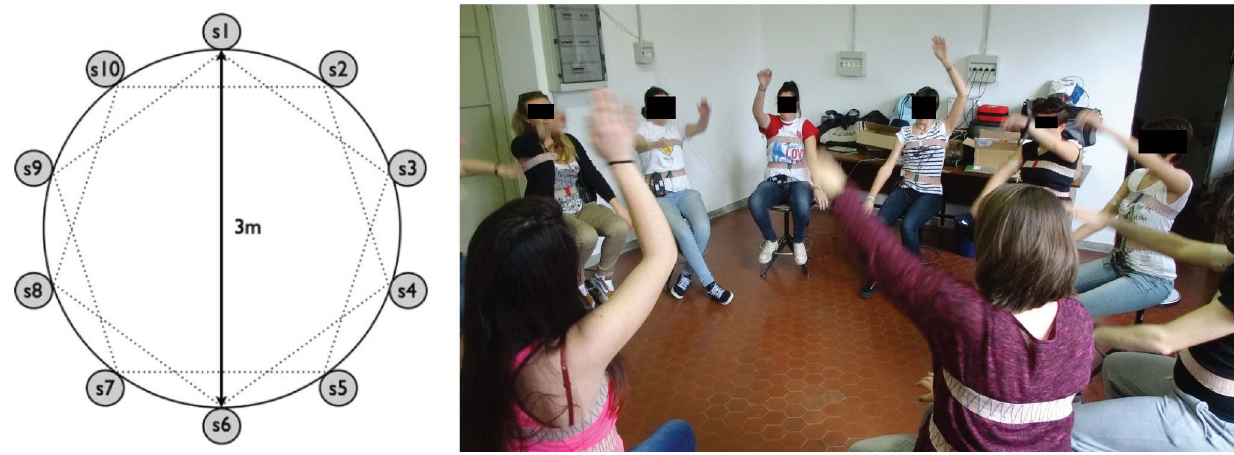
Figure 2. Collective measurement group setup. Left Panel: position of the participants during the study. Right panel: participants of the study during the protocol. The individuals in this manuscript gave written informed consent, as outlined in the PLOS consent form, to participate in the study and to publish their case details. The Ethics committee of the University of Pavia, Italy approved the study protocol.